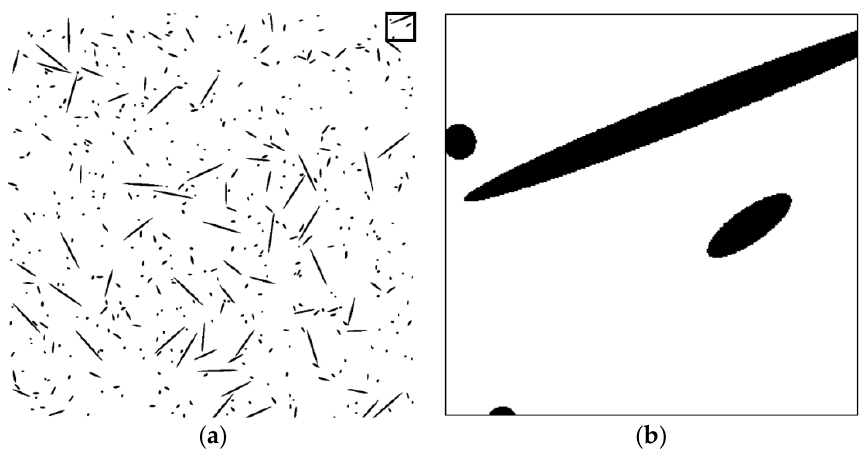
Figure 8. Artificial fiber images with a diameter of 25 pixels in a three ‐ dimensional random distribution in the area of 5000 pixels by 5000 pixels (I25 ‐ 3): ( a ) section image and ( b ) magnified image.